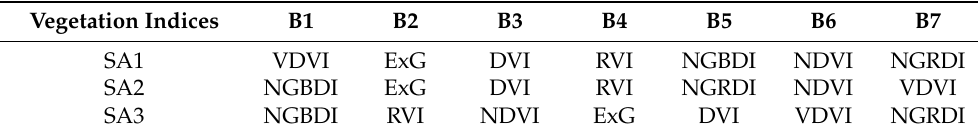
Table A2. The importance ranking of the vegetation indices.